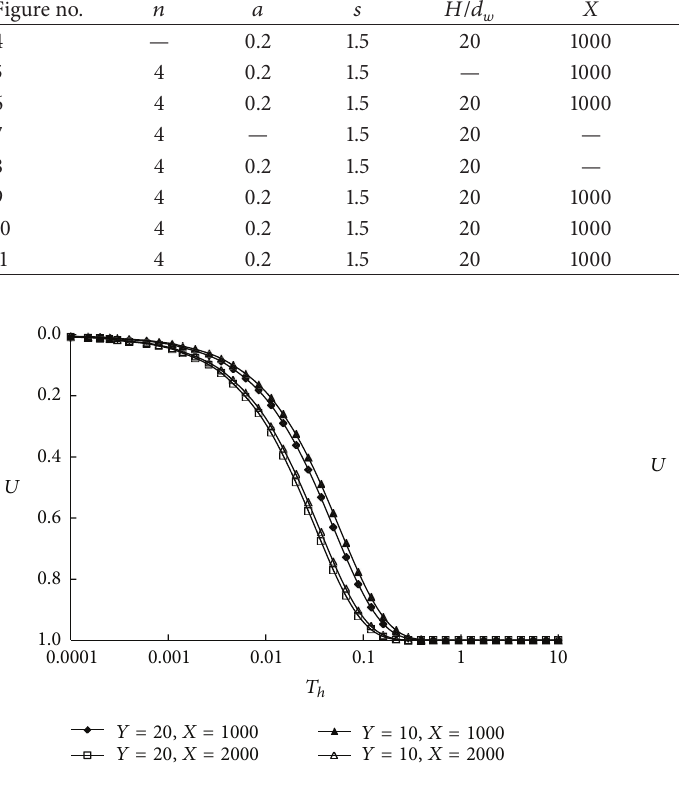
Figure 6: Influence of 𝑋 and 𝑌 on consolidation process.